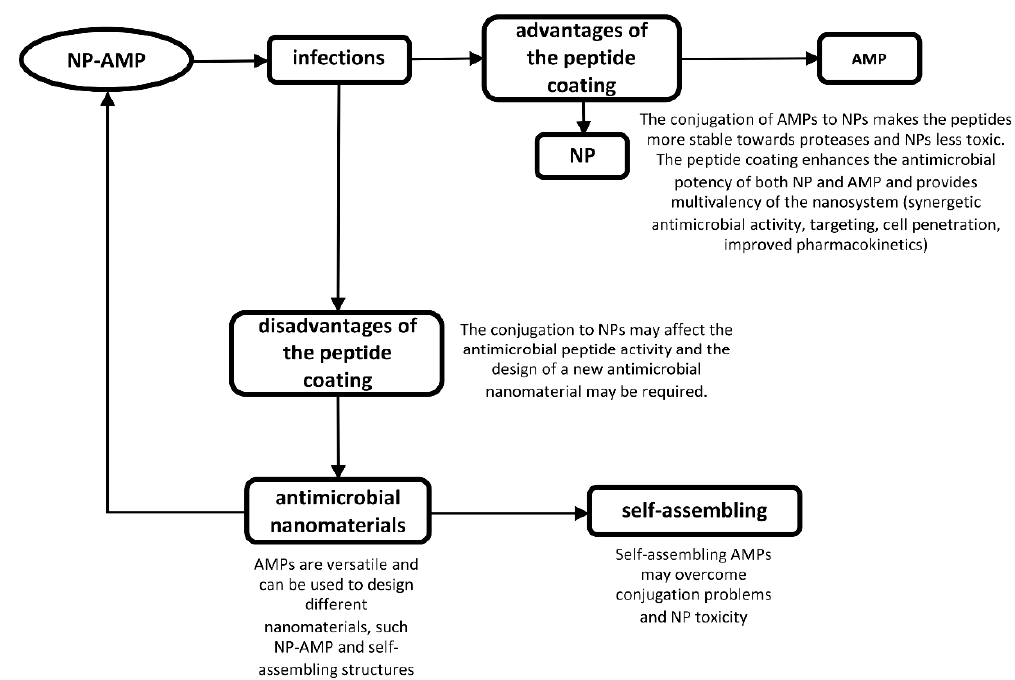
Figure 2. Coating of nanoparticles with antimicrobial peptides is a promising strategy to overcome the drawbacks of the nanoparticles and peptides themselves and improve their action with a synergistic effect. Moreover, the conjugation may affect the peptide properties and the design of new antimicrobial nanomaterials is required.